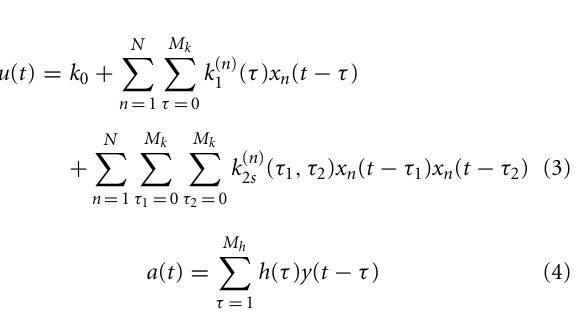
FIGURE 2 | MIMO signal model and MISO memory decoding model. The MIMO signal model predicts the output spatio-temporal patterns of spikes based on the ongoing input spatio-temporal patterns